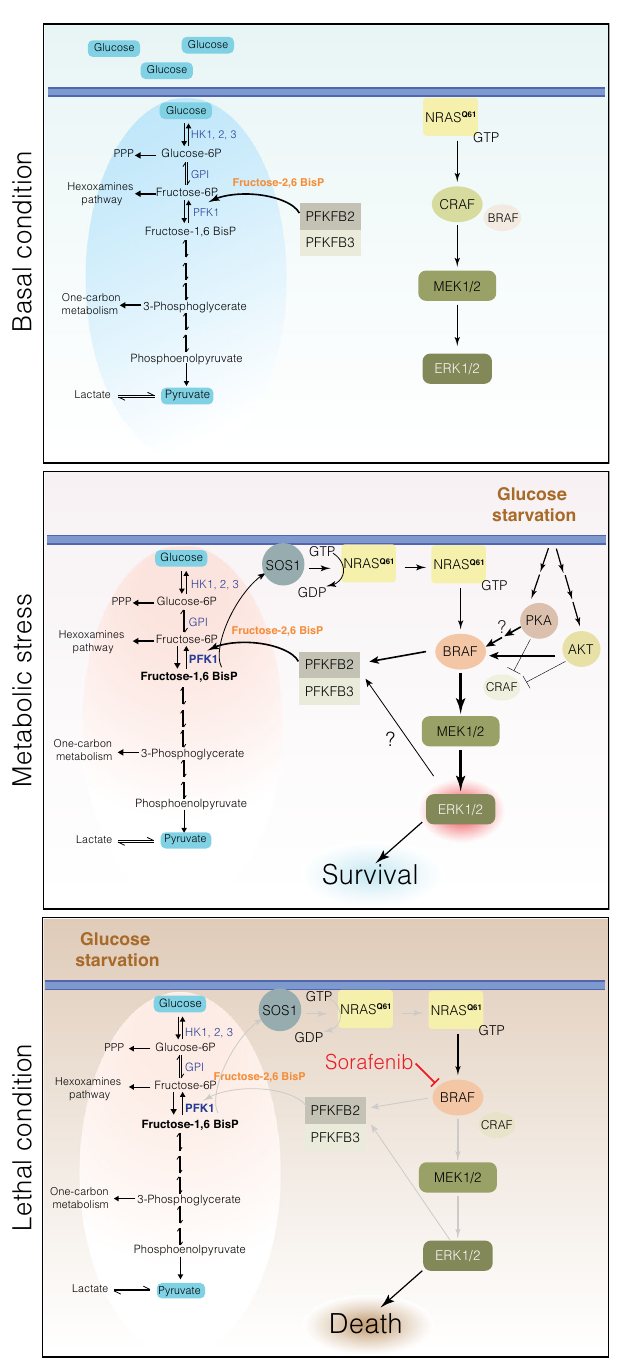
Fig. 9 | Schematic representation of the proposed mechanism: under basal conditions, NRAS Q61 mutant melanoma cells are dependent on glucose meta- bolism and preferentially use CRAF to signal through ERK1/2. Schematic representation of the proposed mechanism: Under basal conditions, NRAS Q61 mutant melanoma cells are dependent on glucose metabolism and preferentially useCRAFtosignalthroughERK1/2.UponGSPKAandAKTareactivated,promoting concomitant CRAF inactivation and BRAF activation and generating a feedback loop to sustain glycolysis. This involves the activation of the kinase activity of PFKFB2/3 that results in the production of fructose-2,6BisP, which in turn allos- terically activates PFK1, inducing the generation of fructose-1,6BisP. This metabo- lite,under metabolicstress,activatesSOS1, promoting the activationof NRAS Q61 by exchanging GDP for GTP, leading again to the activation of BRAF and resulting in cell survival. Treating cells under this condition with sorafenib abolishes BRAF downstream signals, leading to cell